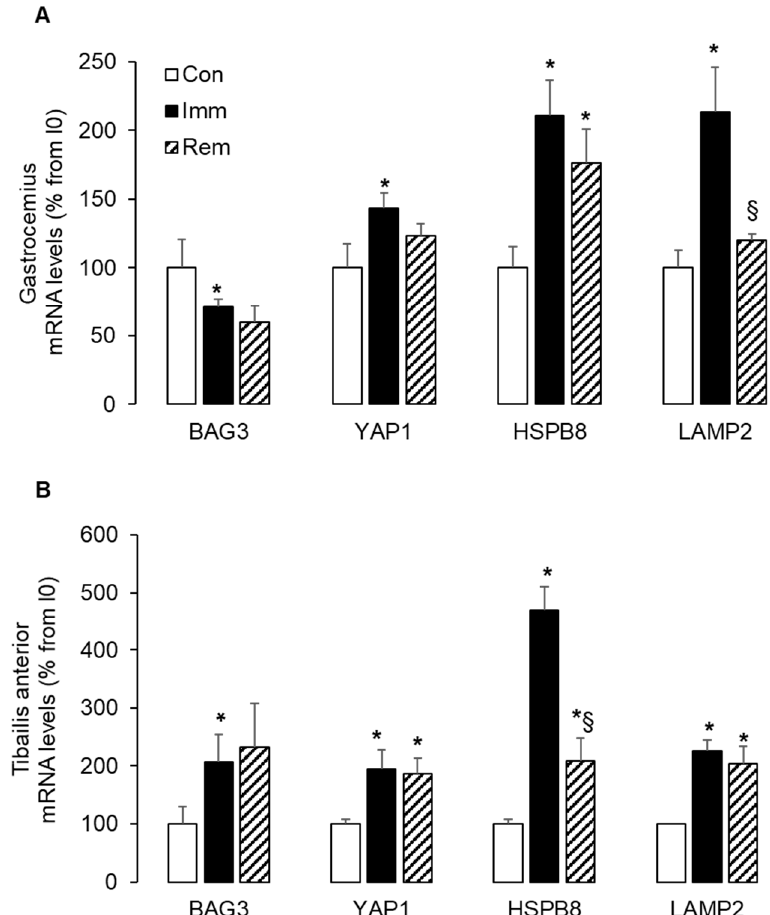
Figure 6. CASA (cross-section area) pathway was largely induced in immobilized and remobilized TA. The mRNA levels for BAG3, HSPB8, LAMP2, and YAP1 were measured in the GA ( A ) and the TA ( B ) by RTqPCR and were normalized using 18S rRNA. Data were expressed as % from the Con group. Statistical differences were assessed by ANOVA, as described in Materials and Methods. * p < 0.05 vs. Con, § p < 0.05 vs. Imm; Con, non-immobilized rats; Imm, immobilized; Rem, remobilized.